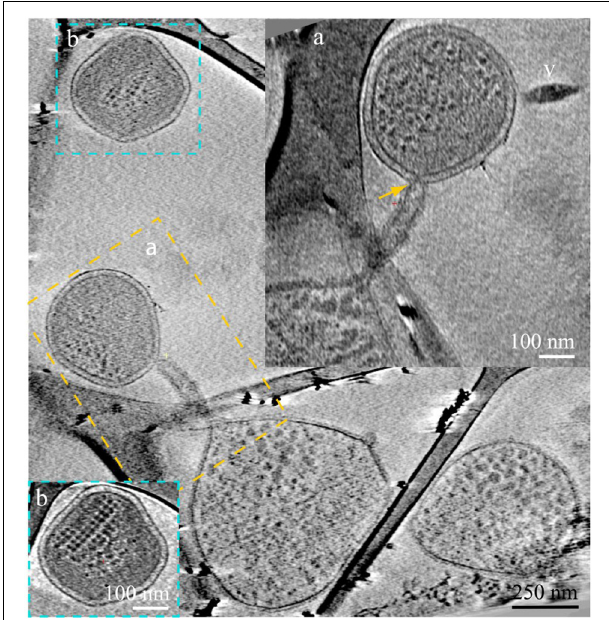
FIGURE 4 | ARMAN— Thermoplasmatales inter-species associations and viral infection processes. Slices from a 3D cryo-ET reconstruction. A Thermoplasmatal cell and an ARMAN cell—enclosed within the dash yellow box, are connected through a remarkable tubular appendage; the region within the dash yellow box is magnified as inset (A) in a slice at a different angle. The “arm-shape” connection extends the Thermoplasmatal cytoplasmic compartment and punctures the cell wall of ARMAN establishing an inter-species cytoplasmic bridge (yellow arrow). An elongated virus is partially in plane to the right (v). The cell within the blue box is shown in inset (B) in a slice at a different angle. The very regular ladder-like series of high contrast elements are putative polysomes. These cells are of an unknown species and are often found connected to Thermoplasmatal cells through pili, as shown in Figure 6 with more detail.